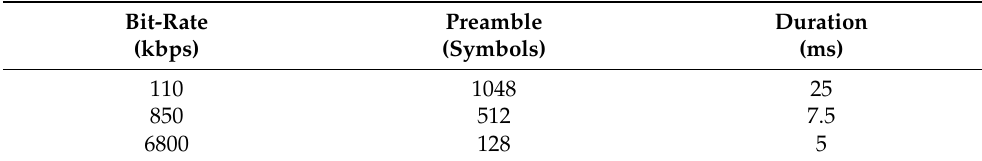
Figure 4. Dynamic registration to a cell provisioned with a 2-timeslots CAP and a single reserved tag, without the need for re-scheduling UWB-TSCH communications. Table 2. TWR timeslot